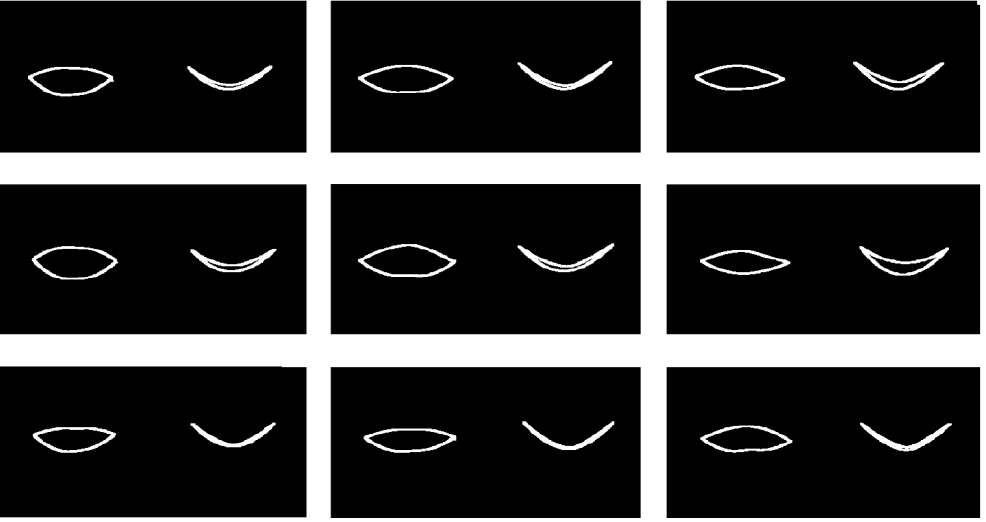
Figure 10. Visualization of the first mode of variation via mPCA at level 1 in the frontal/coronal plane (left) and horizontal plane (right) in each image. ( Left Column ) start of the smile; ( Middle Column ) mid-point (apex or plateau) of the smile; ( Right Column ) end of the smile. ( Top row ) mean shape trajectory; ( Middle Row ) mean shape trajectory minus √𝜃 11 × first mode of variation via mPCA at level 1; ( Bottom Row ) mean shape trajectory plus √𝜃 11 × first mode of variation via mPCA at level 1.